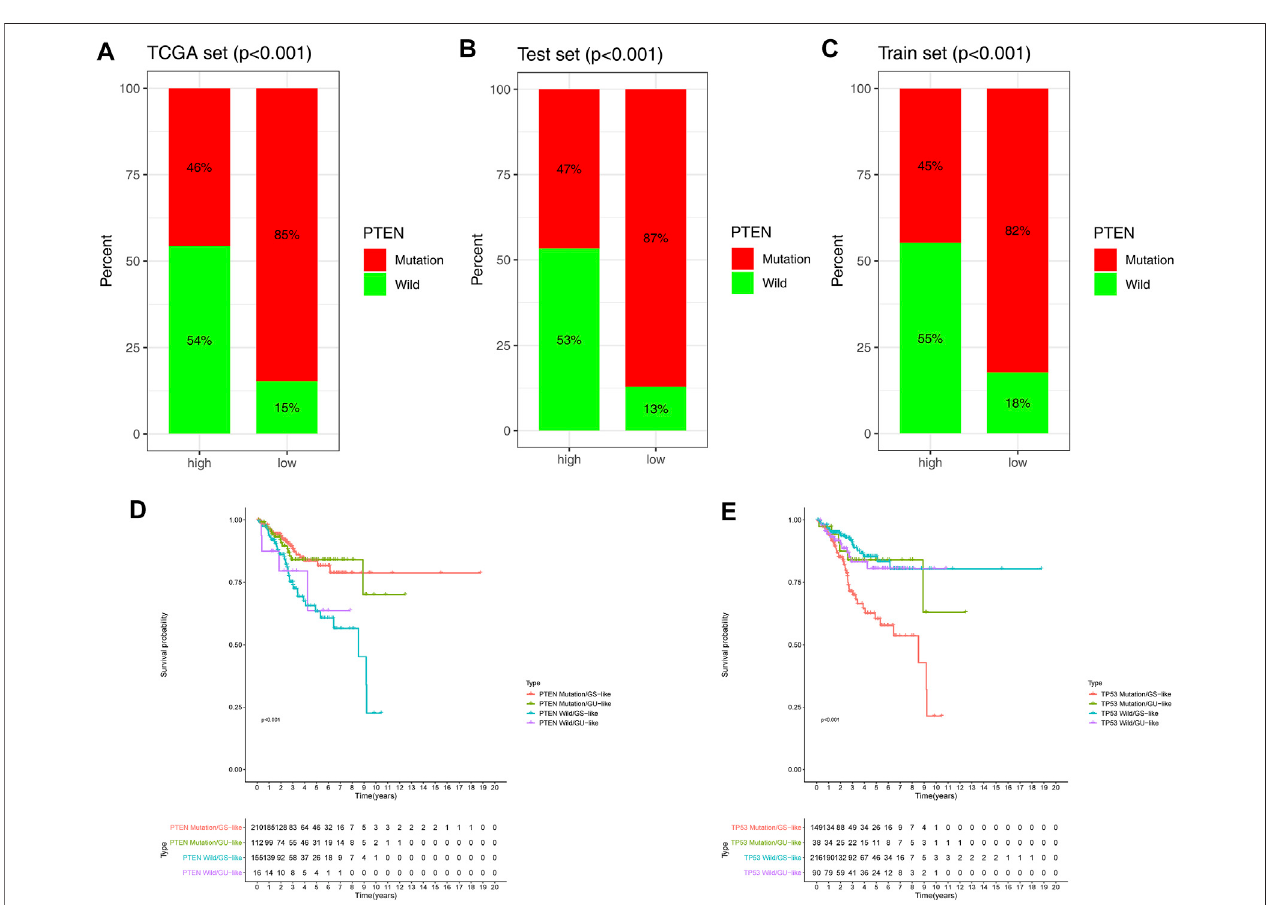
FIGURE 5 | Combined survival analysis of the GILncSig and PTEN mutation. Proportion of PTEN mutation in the high- and low-risk groups in the TCGA set (A) , testing set (B) ,andtrainingset (C) . (D,E) Kaplan – MeiercurveswereusedtoanalyzetheOSofPTENand TP53inmutation/GS-like, mutation/GU,wild/GS,and wild/GU